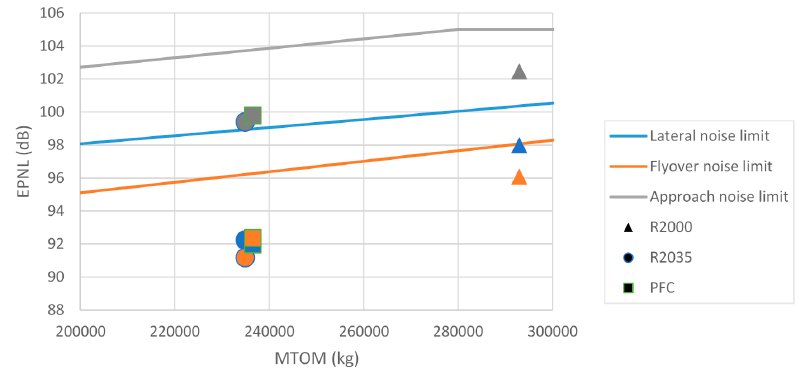
Figure 39. Noise emissions assessments results for the CENTRELINE R2000, R2035 & PFC aircraft.